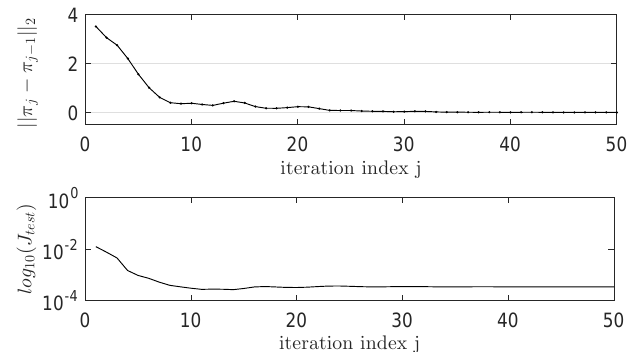
Figure 6. The LP-IMF-AVI convergence on TITOAS ( c (cid:13) 2019 IEEE